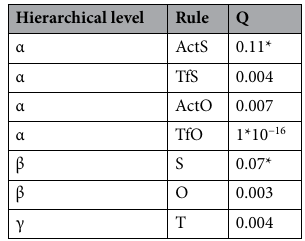
Table 6. Q index comparison between static and dynamic modularity. Only ActS and S rules show a significant increment of Q values ( p < 0.001) when compared to the random model.